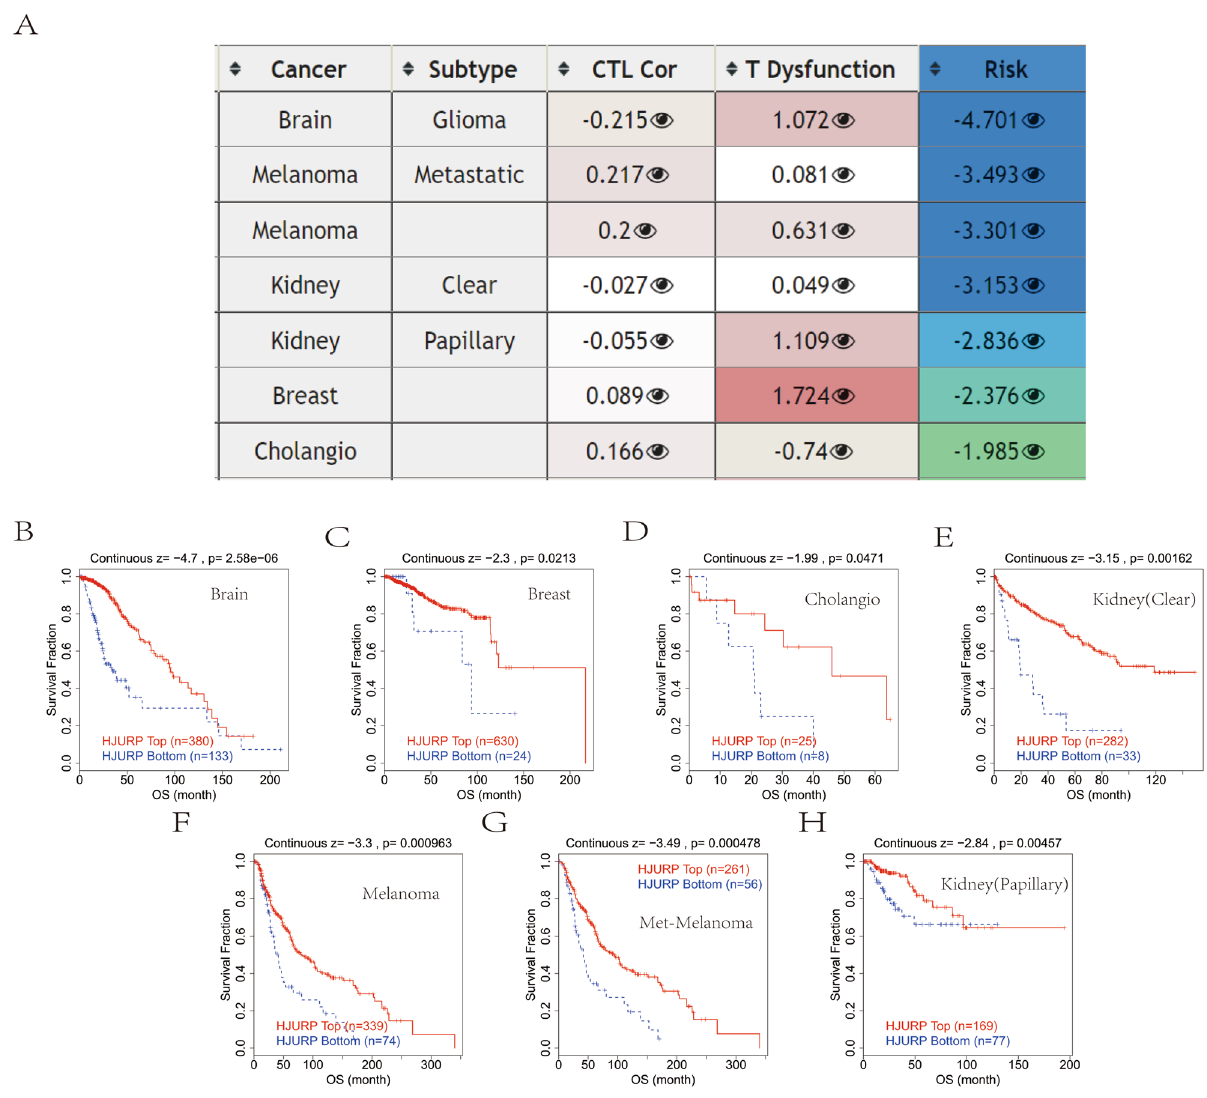
Figure 4. The changes caused by the methylation status of HJURP in different cancers ( A ). HJURP was positively associated with dysfunctional T cells and negatively with survival time in different tumors ( B–H